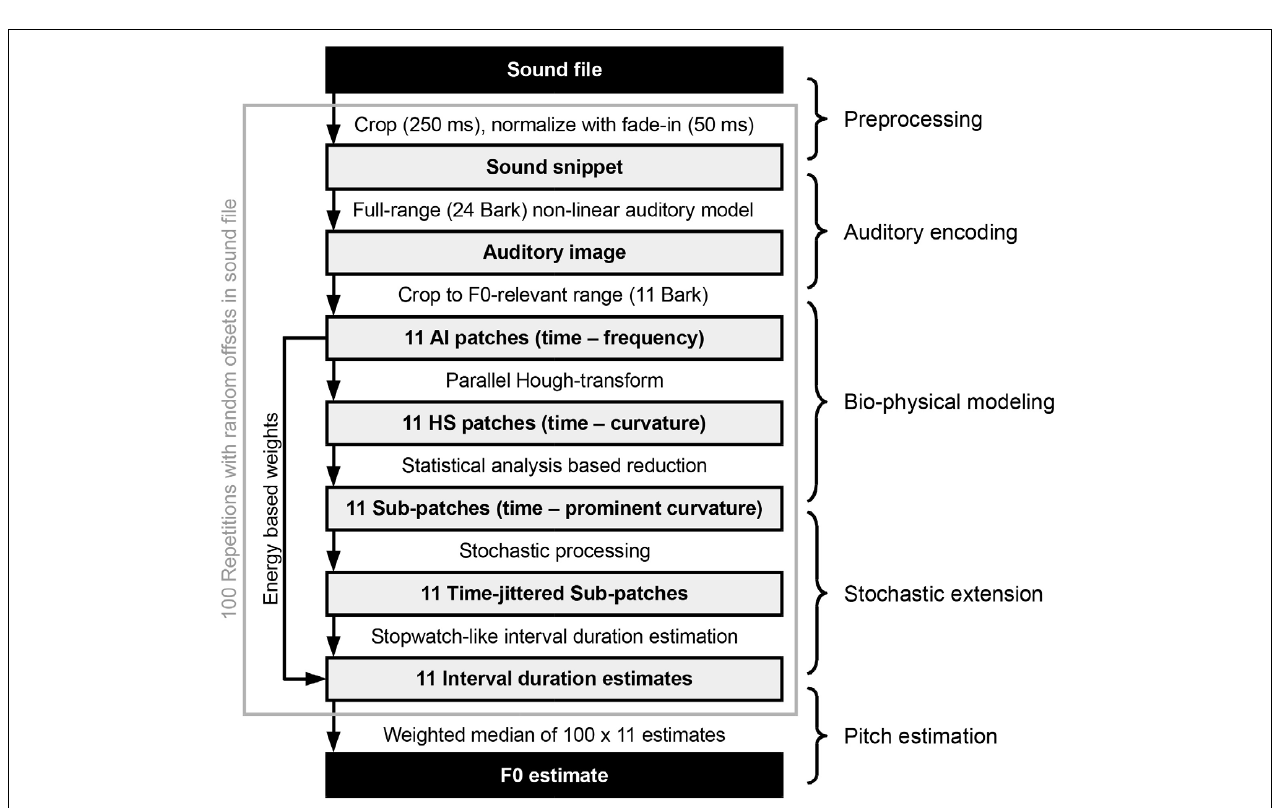
FIGURE 2 | Overview of the processing steps from a single sound file to the pitch estimate (Adapted from Harczos and Klefenz, 2018).